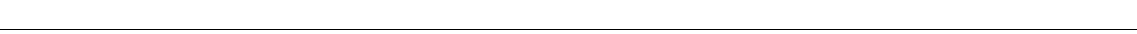
Figure 4 | Post-synaptic TRPV1 promotes excitatory innervation. ( a ) Quadruple immunocytochemistry images of hippocampal neurons immunostained for TRPV1, vGluT1, syt1 lumenal antibody internalized by recycling synaptic vesicles during depolarization, and MAP2, in the indicated conditions; scale bar, 20 m m. ( b ) Higher magnification images of vGluT1 and MAP2 on TRPV1-expressing neurons in hippocampal cultures; scale bar, 5 m m. ( c ) Quantification of excitatory synapse number on TRPV1-positive hippocampal neurons normalized to surrounding cells in the indicated conditions. Black asterisks indicate significance between TRPV1-expressing and surrounding neurons in each condition. Blue asterisks indicate significance relative to control for either TRPV1- expressing cells or surrounding cells. ( d ) Quantitation of vGluT1, and syt1 uptake ( e ) intensity in presynaptic terminals contacting TRPV1-expressing neurons, normalized to surrounding neurons, in the indicated conditions. Images used for quantitation were: WTcontrol n ¼ 24, WT 50nM cap. n ¼ 12, WT ( f ) Immunostains of TRPV1, vGAT, lumenal syt1 antibody internalized by recycling synaptic vesicles during depolarization, and MAP2 in the indicated conditions; scale bars, 20 m m. ( g ) Higher magnification images of vGATand MAP2 immunostaining; scale bars, 5 m m. ( h ) Quantitation of inhibitory synapse number (number of vGAT-positive puncta) on TRPV1-expressing neurons normalized to surrounding cells. ( i ) Quantitation of vGAT intensity in presynaptic terminals contacting TRPV1-expressing neurons, normalized to surrounding neurons, in the indicated conditions. ( j ) Quantitation of syt1 uptake in depolarizing conditions in vGAT-positive terminals contacting TRPV1-expressing neurons, normalized to surrounding neurons, in the indicated conditions. Images used for quantitation were: WTcontrol n ¼ 23, WT 50nM cap. n ¼ 11, WT 1 m M cap. n ¼ 9, WT 1 m M cap. þ 1 m M SB n ¼ 12, WT 1 m M SB n ¼